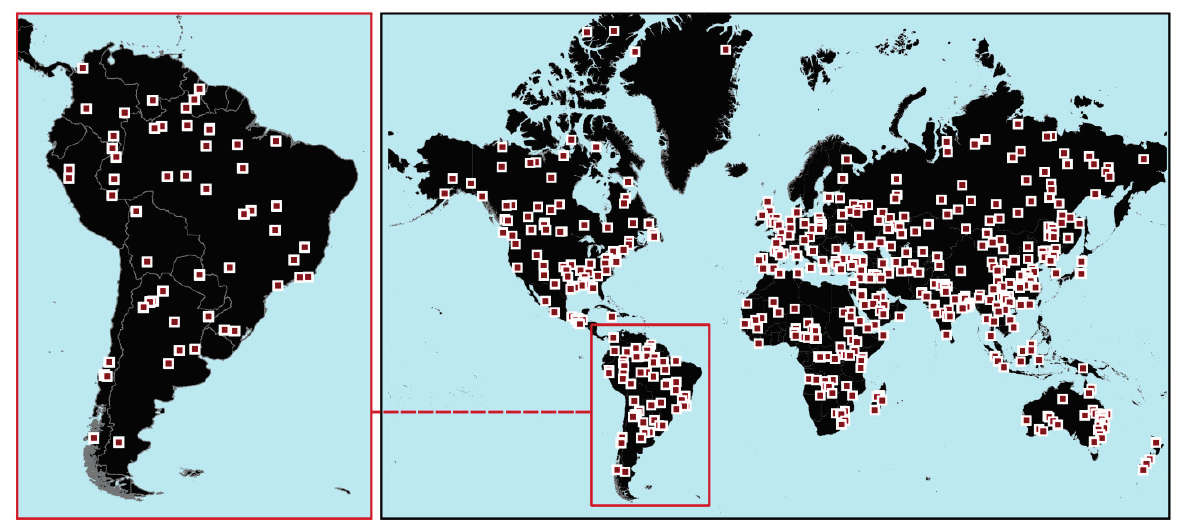
Figure 2. Global 5 × 5 km very high resolution reference sites and their location in South